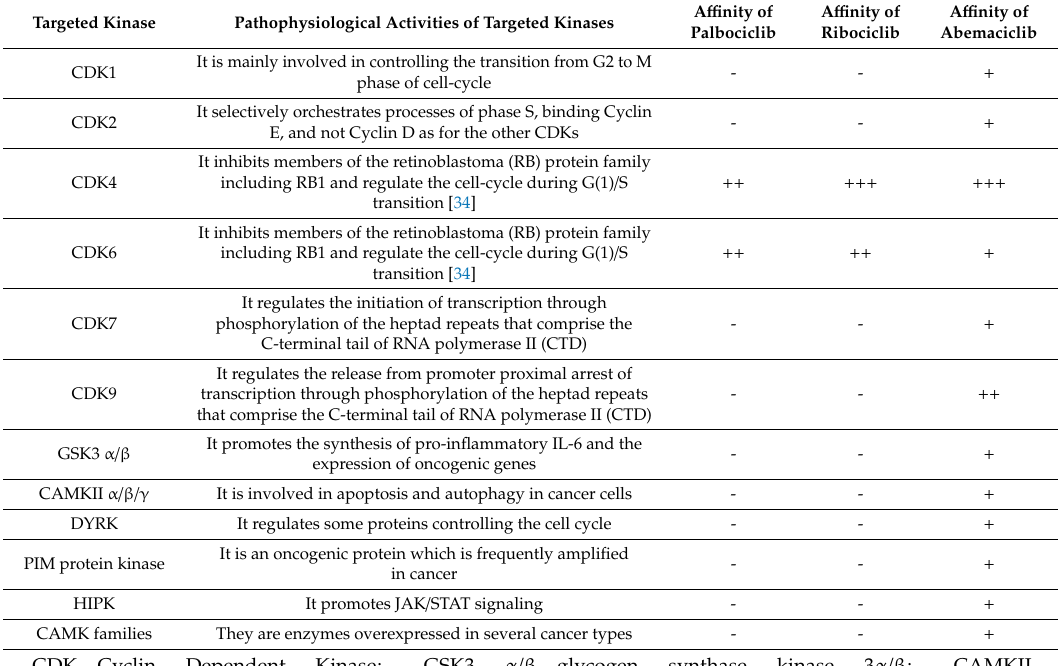
Table 1. Molecular pathways of kinases which are targeted by palbociclib, ribociclib and abemaciclib. The grading of a ffi nity between CDKis and each target kinase is arbitrary expressed by -, no a ffi nity; + , presence of a ffi nity; ++ , high a ffi nity; +++ , very high a ffi